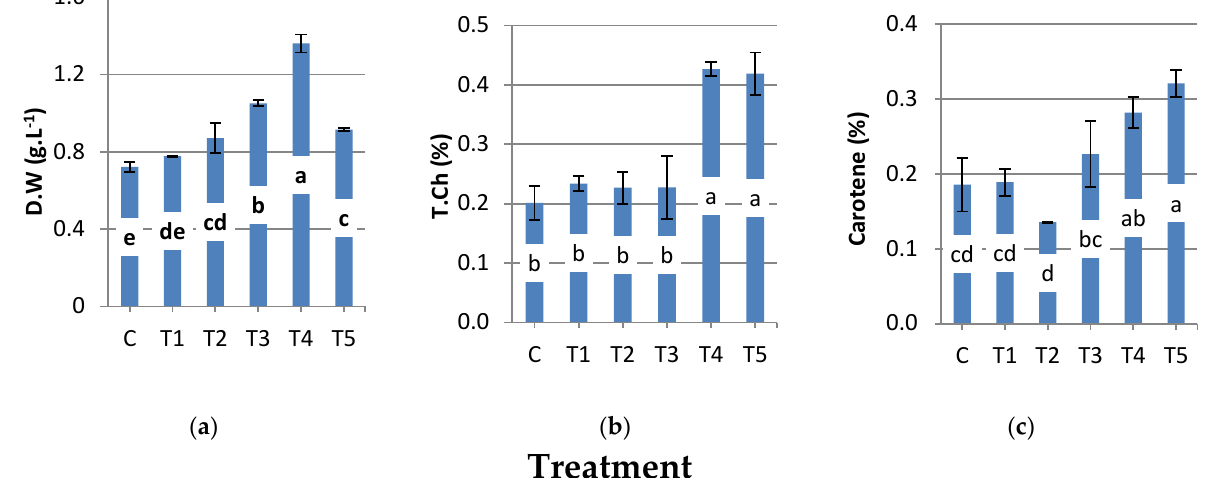
Figure 2 . ( a ) Dry weight (g L − 1 ), ( b ) total chlorophyll (%), and ( c ) total carotenes (%) of N. oculata grown under different nutrient concentrations and 10% bagasse extract. C: control (medium); T1: 100% medium with 10% bagasse extract; T2: 75% medium with 10% bagasse extract; T3: 50% medium with 10% bagasse extract; T4: 25% medium with 10% bagasse extract; and T5: 0.0% medium with 10% bagasse extract. Groups with different letters in the legends of each graph indicate significant differences (Linear-Mixed Model Repeated Measures ANOVA, sig. p < 0.05)